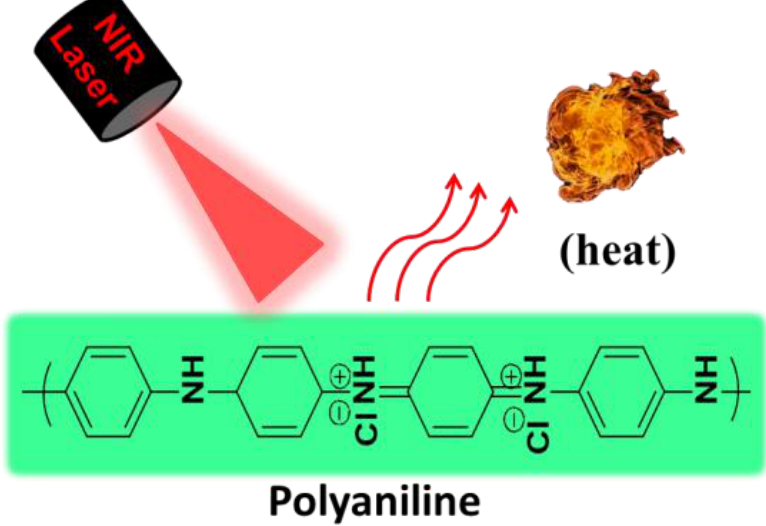
Figure 1. Schematic illustration for photothermal property of PANI.